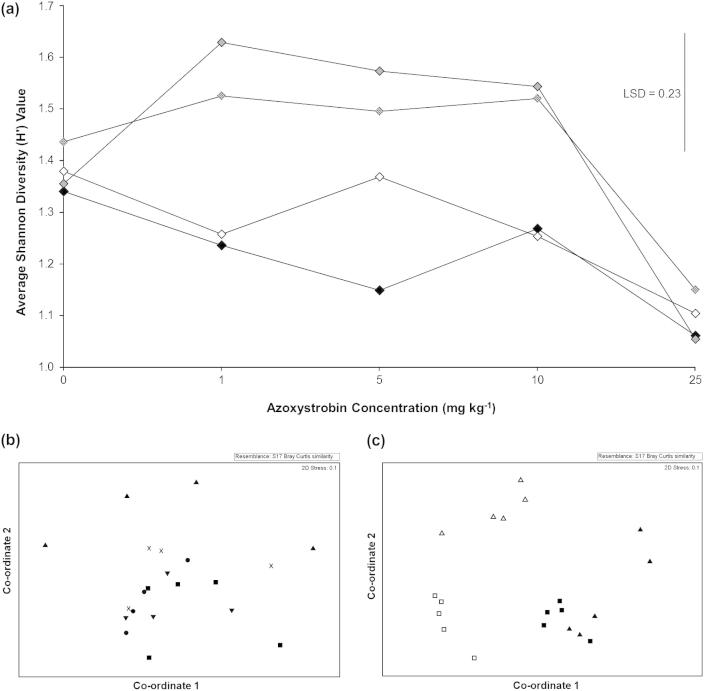
(a) The average Shannon diversity index (H′) of fungal communities recorded using the EF4f/EF3r primer pair over 4 months following azoxystrobin application. ♦ 1 month ♢ 2 months  3 months  4 months. Each data point represents the mean of 4 experimental samples. (b) NMDS analysis of fungal community structure determined using the primer pair EF4f and EF3r and grouped by Azoxystrobin concentration. ■ 0 mg kg−1 ▾ 1 mg kg−1 ● 5 mg kg−1 × 10 mg kg−1 ▴25 mg kg−1. Each data point represents the mean of 4 experimental replicates at an individual time point. (c) NMDS analysis of fungal community structures using extracted DNA and RNA 1 month post azoxystrobin application. Each data point represents an experimental replicate. ■ 0 mg kg−1 DNA □ 25 mg kg−1 DNA ▴ 0 mg kg−1 RNA Δ 25 mg kg−1 RNA.